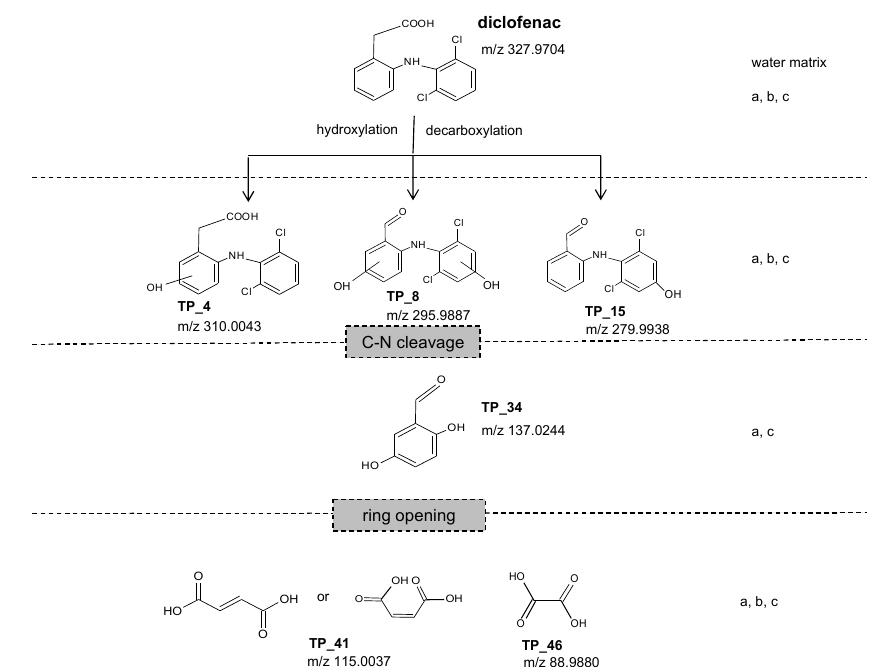
Figure 2. Degradation pathway of DCF and the occurrence of identified transformation products (TPs) in the three water matrices: (a) deionized water, (b) drinking water, and (c) wastewater e ffl uent. Overall, five TPs were identified in all three water matrices at a current density of 292 mA / cm 2 . These contain three structures with two aromatic rings, derived from hydroxylation or Time courses of the formation and degradation of representative TPs are displayed in Figure 3, as percentages of the peak areas in relation to the respective maximum peak area over the applied charge per volume.